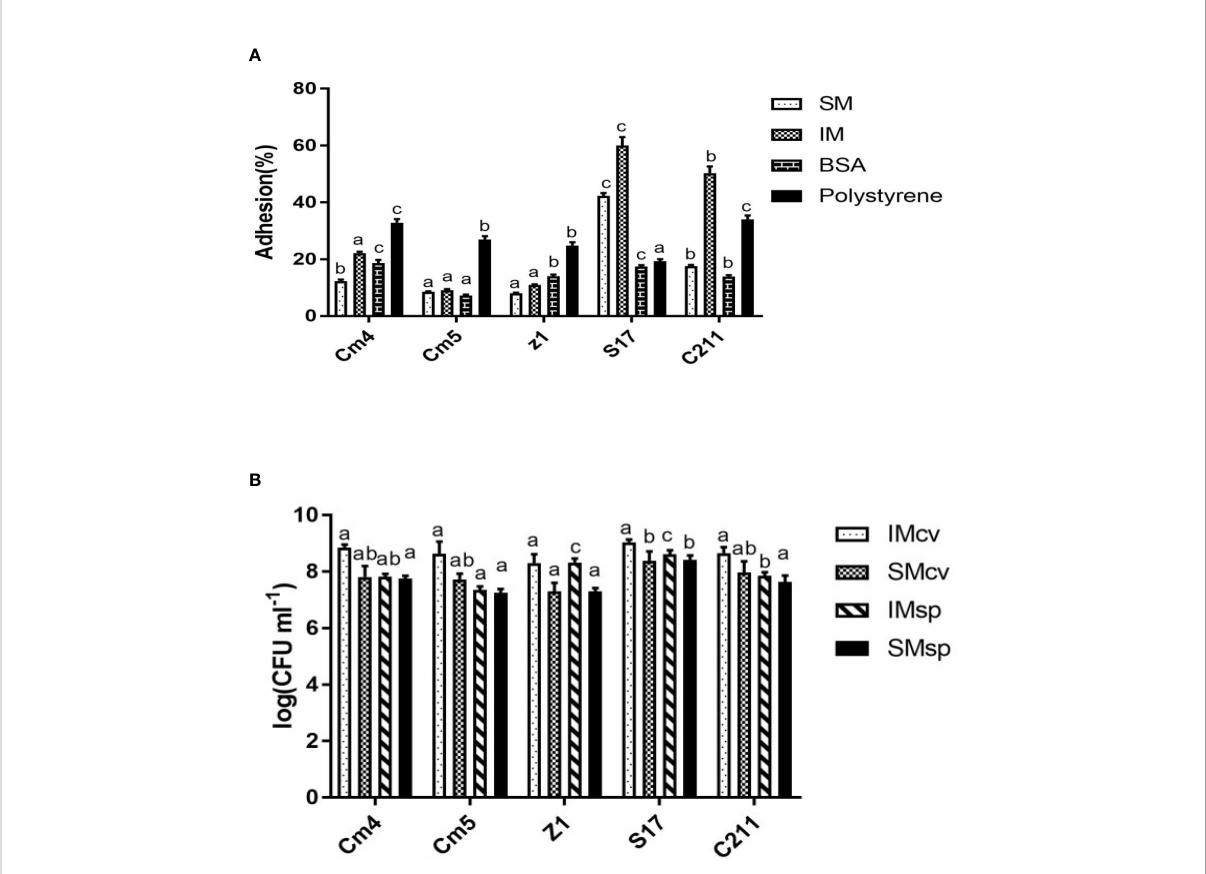
FIGURE 8 (A) Adhesions of spores to fi sh mucus, BSA and polystyrene and (B) Growth of selected strains on intestinal and skin mucus of Sparus aurata . Data are presented as mean ± SD (n=3) with different superscript letters denoting a signi fi cant differences (p<0.05). * IM, intestinal mucus; SM, skin mucus; cv, vegetative cells; sp,